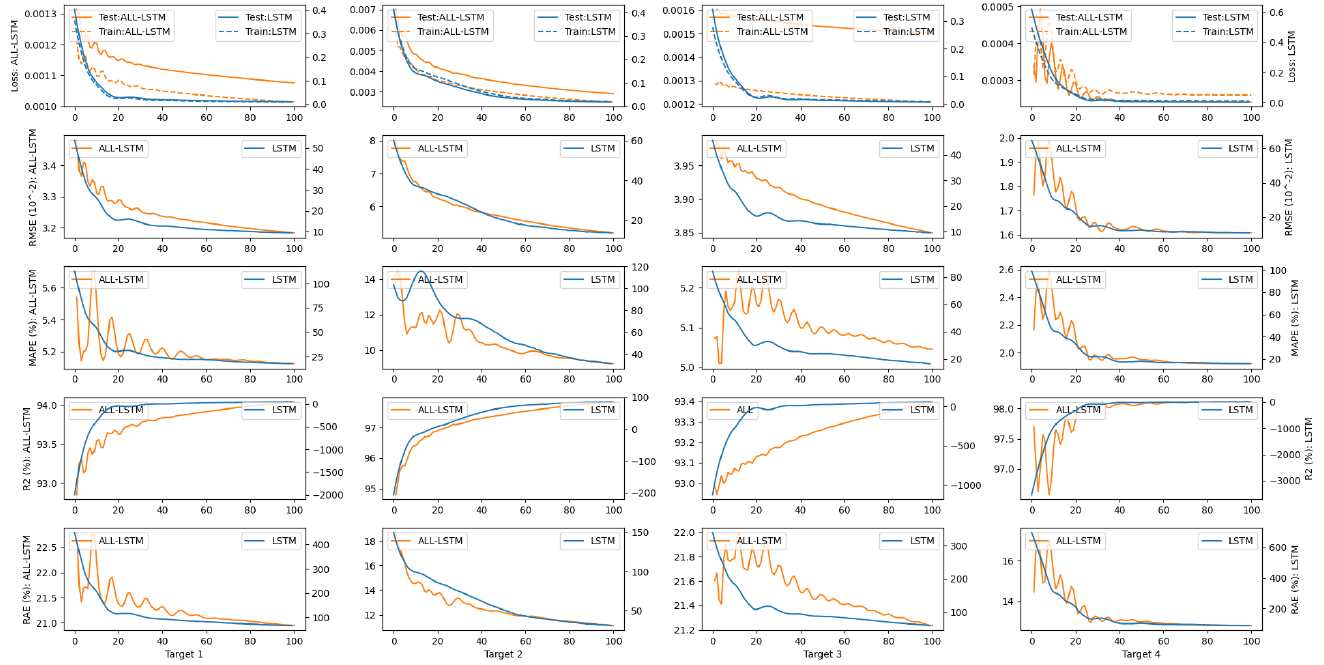
Figure 6. Convergence profiles in Targets 1–4 and few-data scenarios. The left vertical axis is for ALL-LSTM, when the right is for